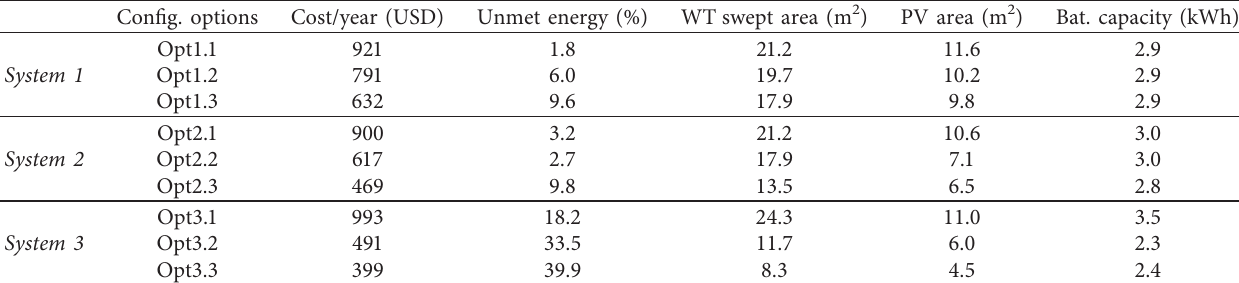
Table 2: Illustrative system configurations for various hybrid renewable energy systems from the component optimal sizing results. Config. options